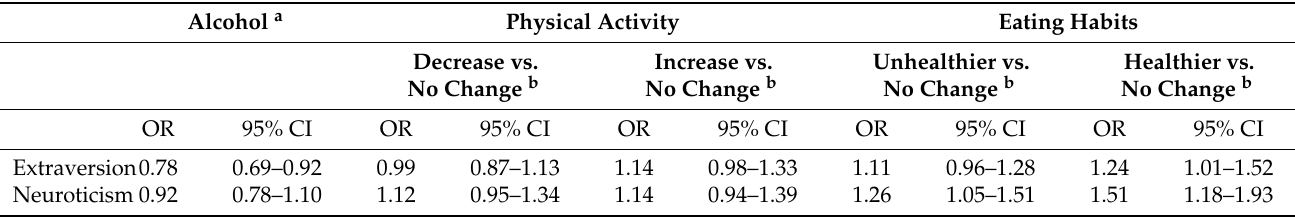
Table 5. Associations of personality traits with perceived changes in health behaviors at the end of emergency conditions ( n =